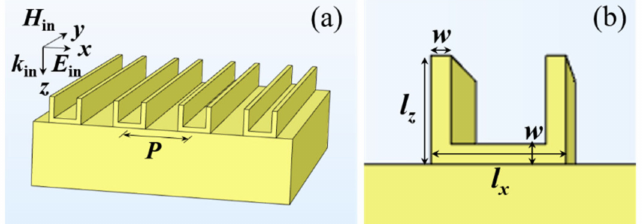
Figure 1. ( a ) Schematic view of the array of the Au VSRRs structure directly on the Au substrate. ( b ) The magnified front views of a unit cell of the Au VSRRs